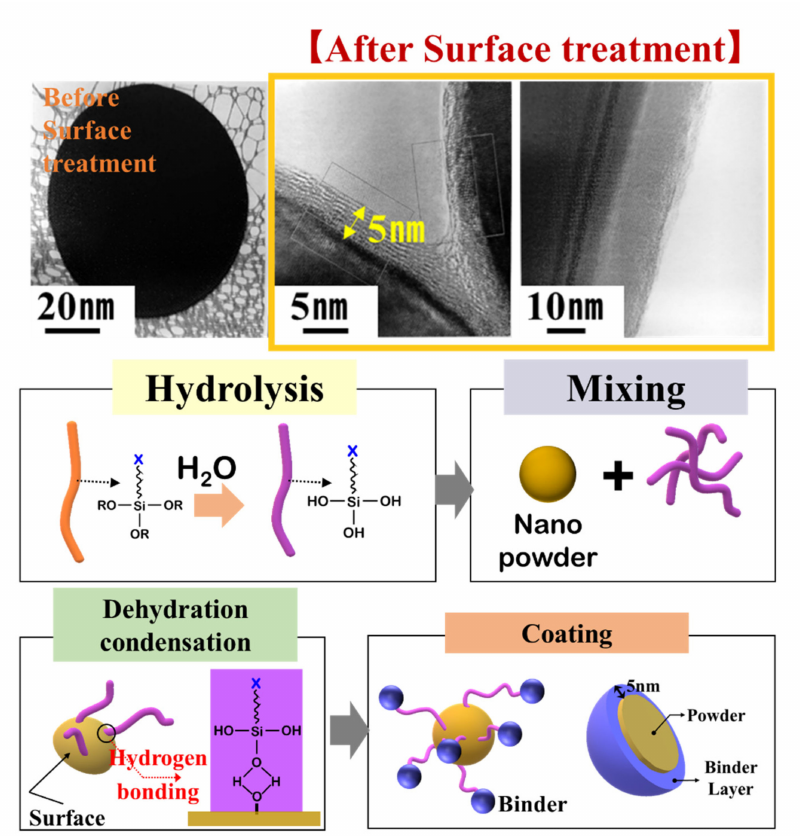
Figure 8. Analysis of bonding mechanism and coating-layer thickness between nanopowder surface and